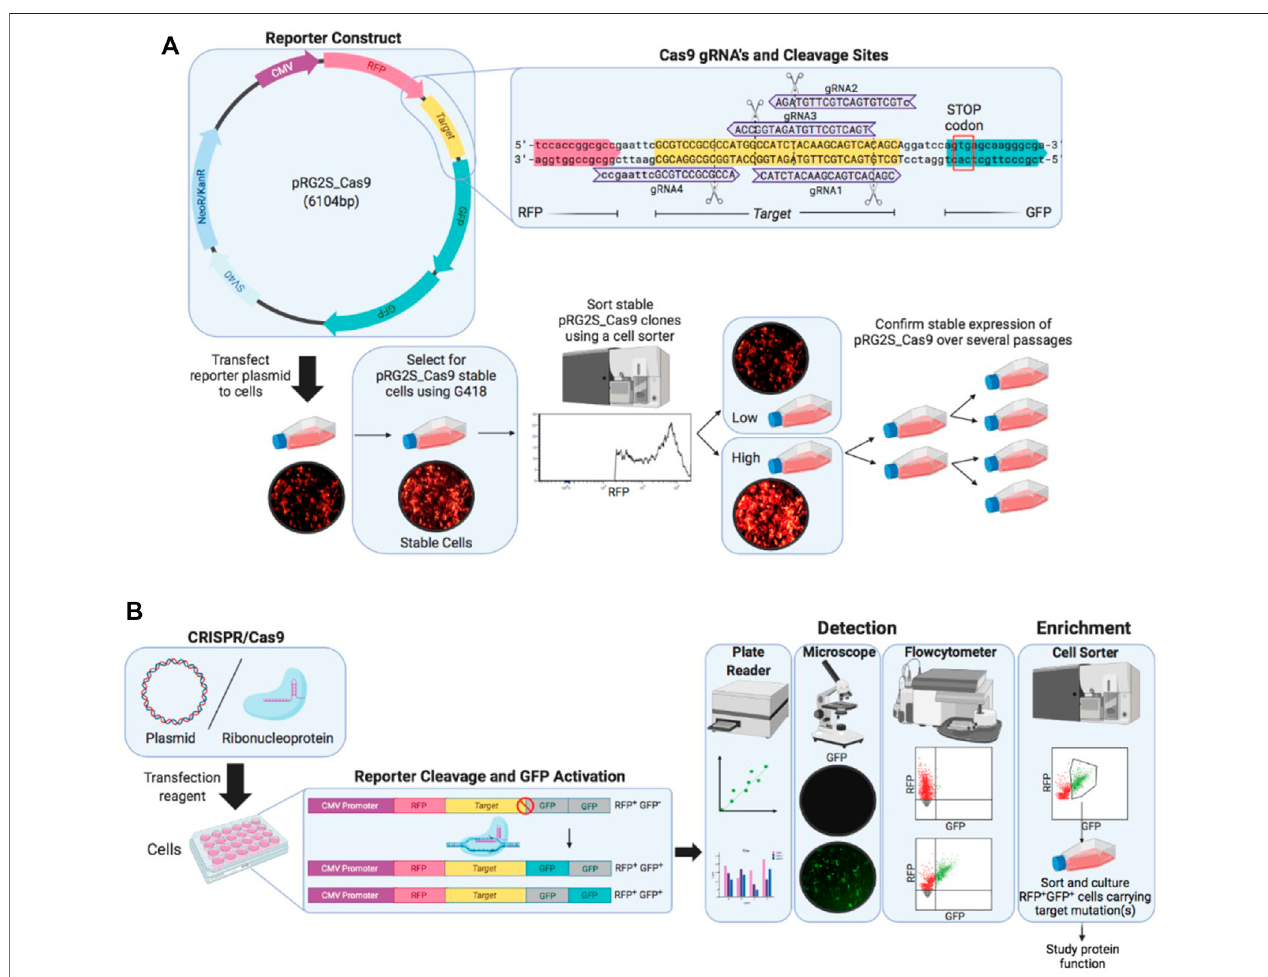
FIGURE 1 | Overview of the stable reporter system for detection of CRISPR-Cas9 induced mutations in human cells. (A) Fluorescent reporter construct map highlighting reporter-guide RNAs (gRNAs) sequences (purple) and binding sites at the Cas9 target sequence (yellow) engineered and cloned using BstXI and BamHI restriction enzymes between RFP (red) and GFP (green) genes. A stable reporter cell line is generated by selection of stable transformants of the fl uorescent reporter construct using G418 antibiotic and sorting stable transformants using a cell sorter. (B) Illustration of the working mechanism of the fl uorescent reporter. The RFP gene (red), upstream ofCas9 target sequence (yellow), isconstitutively expressed underCMVpromoter(purple), while two GFP genes(grey)are clonedoutofframe (+1 and+2)downstreamoftheCas9targetsequenceandtheyareexpressedonlyifasuitableframeshiftmutationoccursthrougherror-pronenon-homologousend-joining (NHEJ)DNArepairafterdouble-strandedbreaksareintroducedbyCas9nucleaseatthetargetsequence.Aframeshiftmutationcircumventsthestop-codonpreventing GFP expression causes either of the GFP genes in-frame to be expressed (green). Cells expressing the reporter construct are treated with CRISPR-Cas9 and gRNA expression plasmid or ribonucleoprotein complex and nuclease activity is detected under a fl uorescence microscope and using fl ow cytometry.